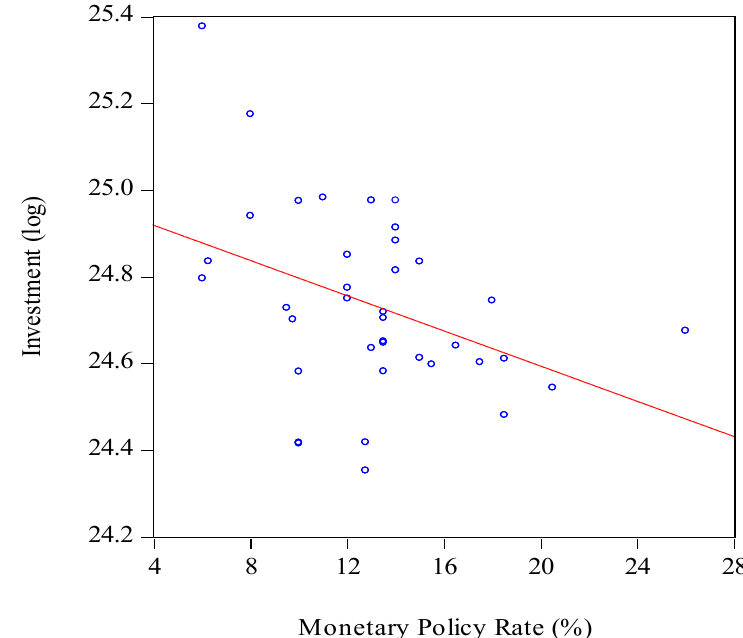
Fig. 1. Investment and MPR, the author’s computation (2020).